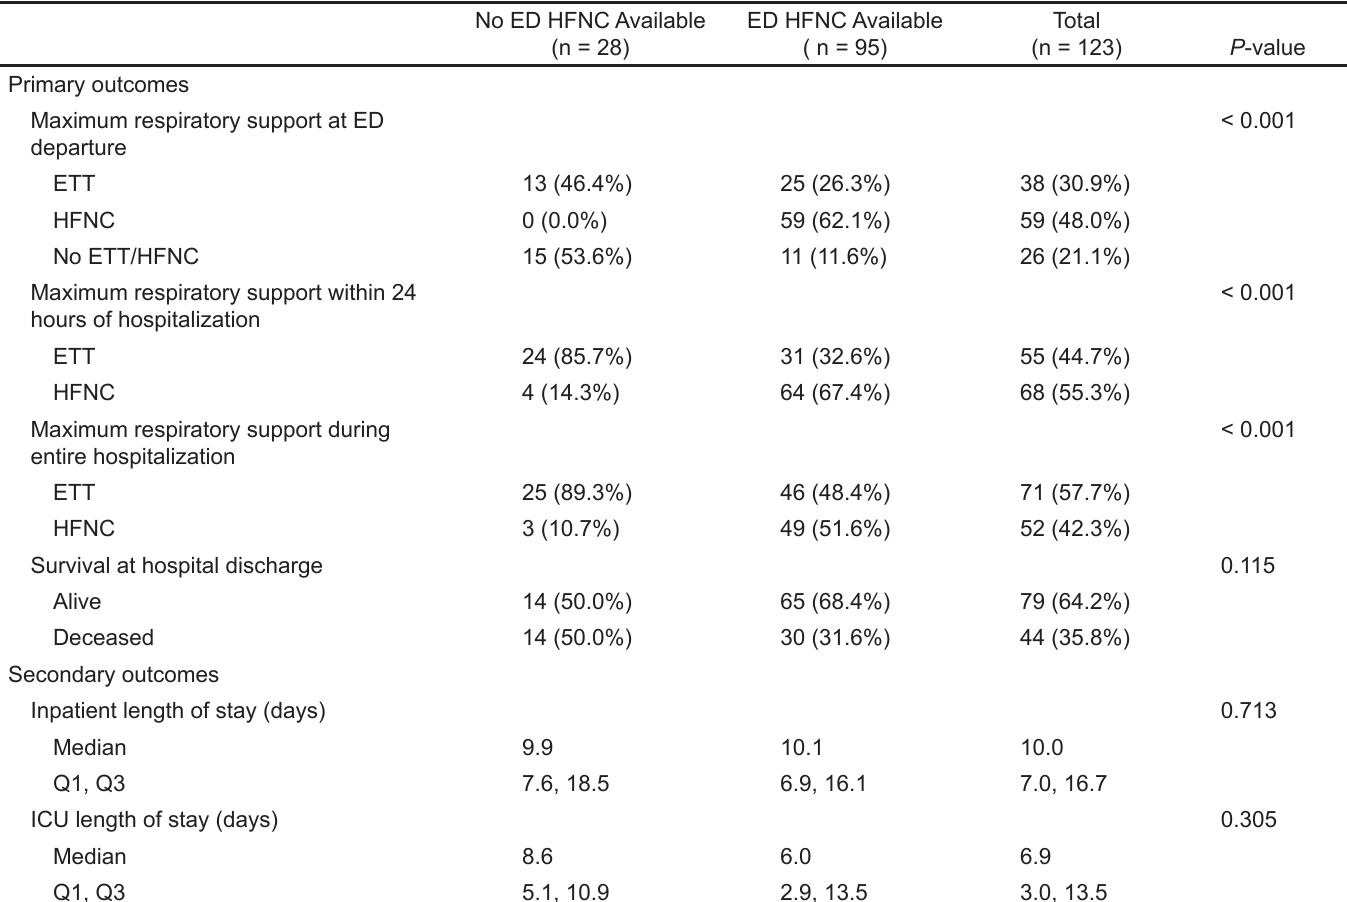
Table 2. Patient outcomes before and sfter the availability of high-flow nasal cannula initiated in the emergency